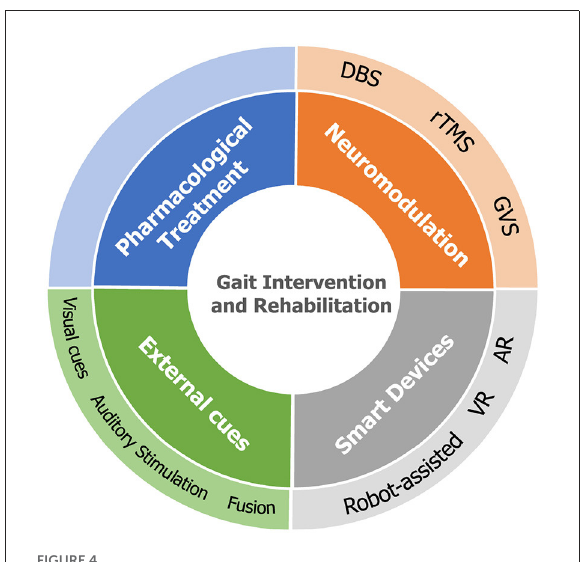
FIGURE4 Four categories of gait intervention methodologies in previous